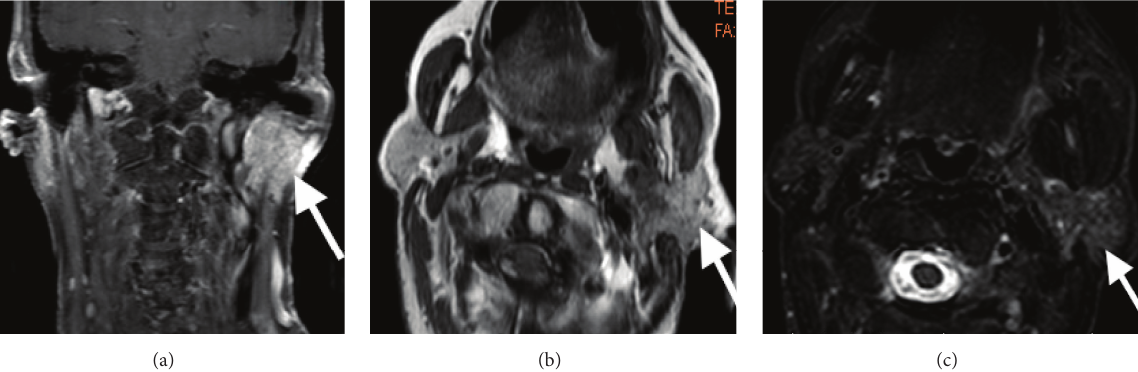
Figure 1: MRI revealing a mass in the deep lobe of the parotid gland abutting the posterior aspect of the lateral pterygoid muscle, likely extending towards the stylomastoid foramen exhibiting low T1 signal intensity in (a) coronal and (b) axial planes as well as low STIR signal intensity in (c) axial